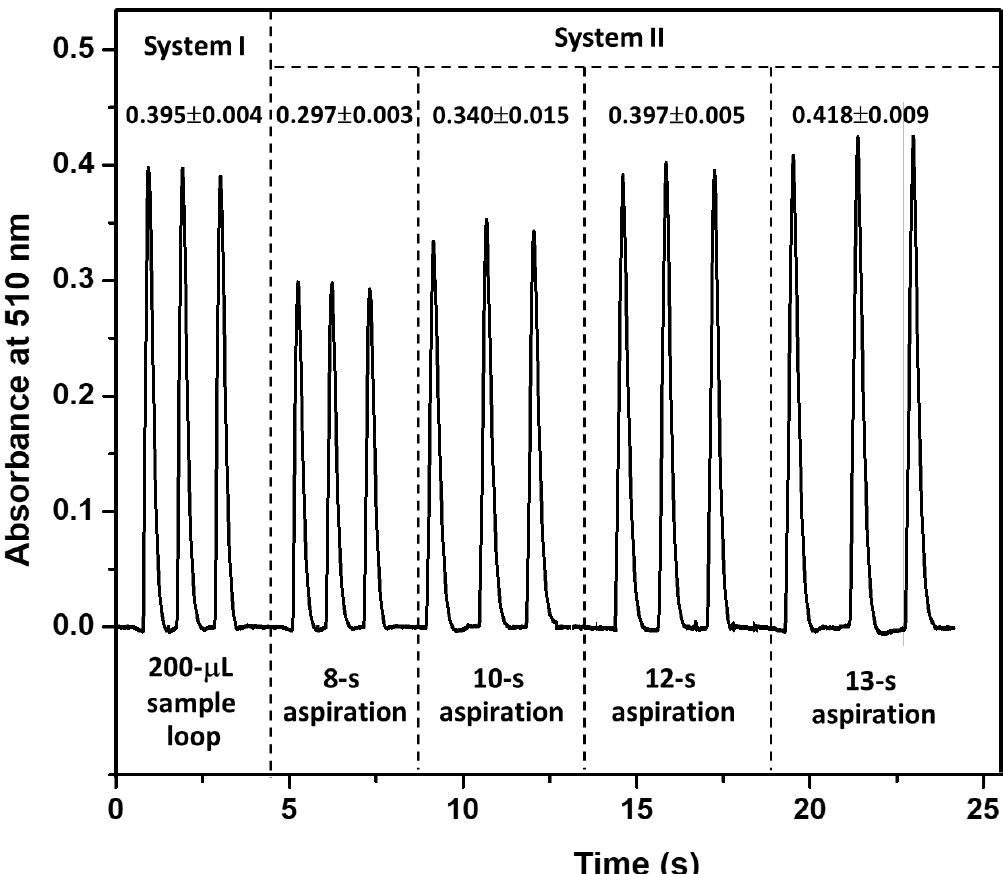
Figure A2. Comparison of absorbance signals of red dye solution obtained from System I using the 200- µ L sample loop and from System II with various aspiration times (8–13 s) for sample introduction.